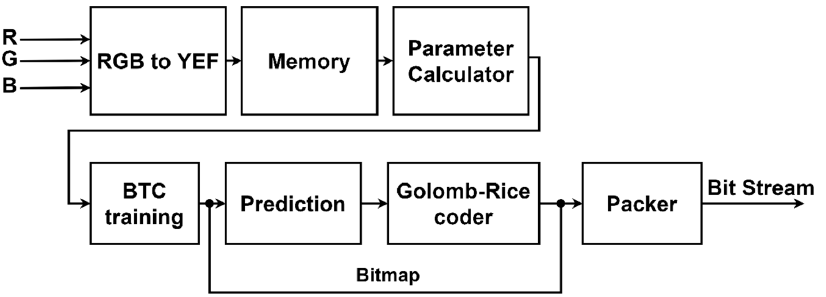
Figure 1. The image compression algorithm flowchart enhanced from BTC proposed in this research.